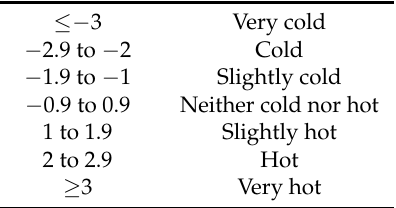
Table 7. Interpretive bands for the Brazilian Subtropical Index (BSI).